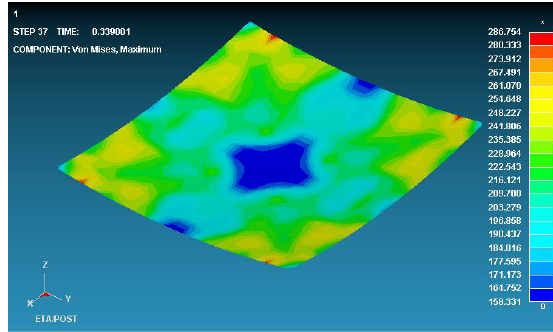
Figure 7. The stress-distribution diagram.